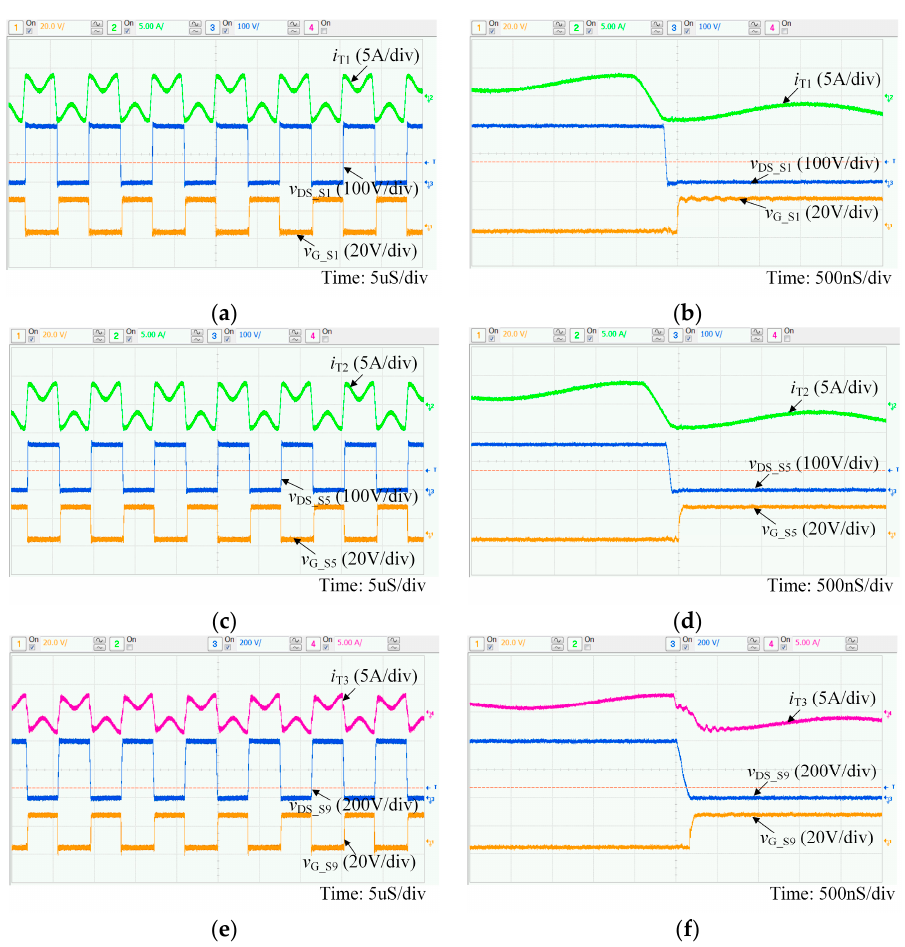
Figure 18. Experimental results of MR-TP-BDC under reverse half load condition: ( a , b ) port 1; ( c , d ) port 2; ( e , f ) port 3.